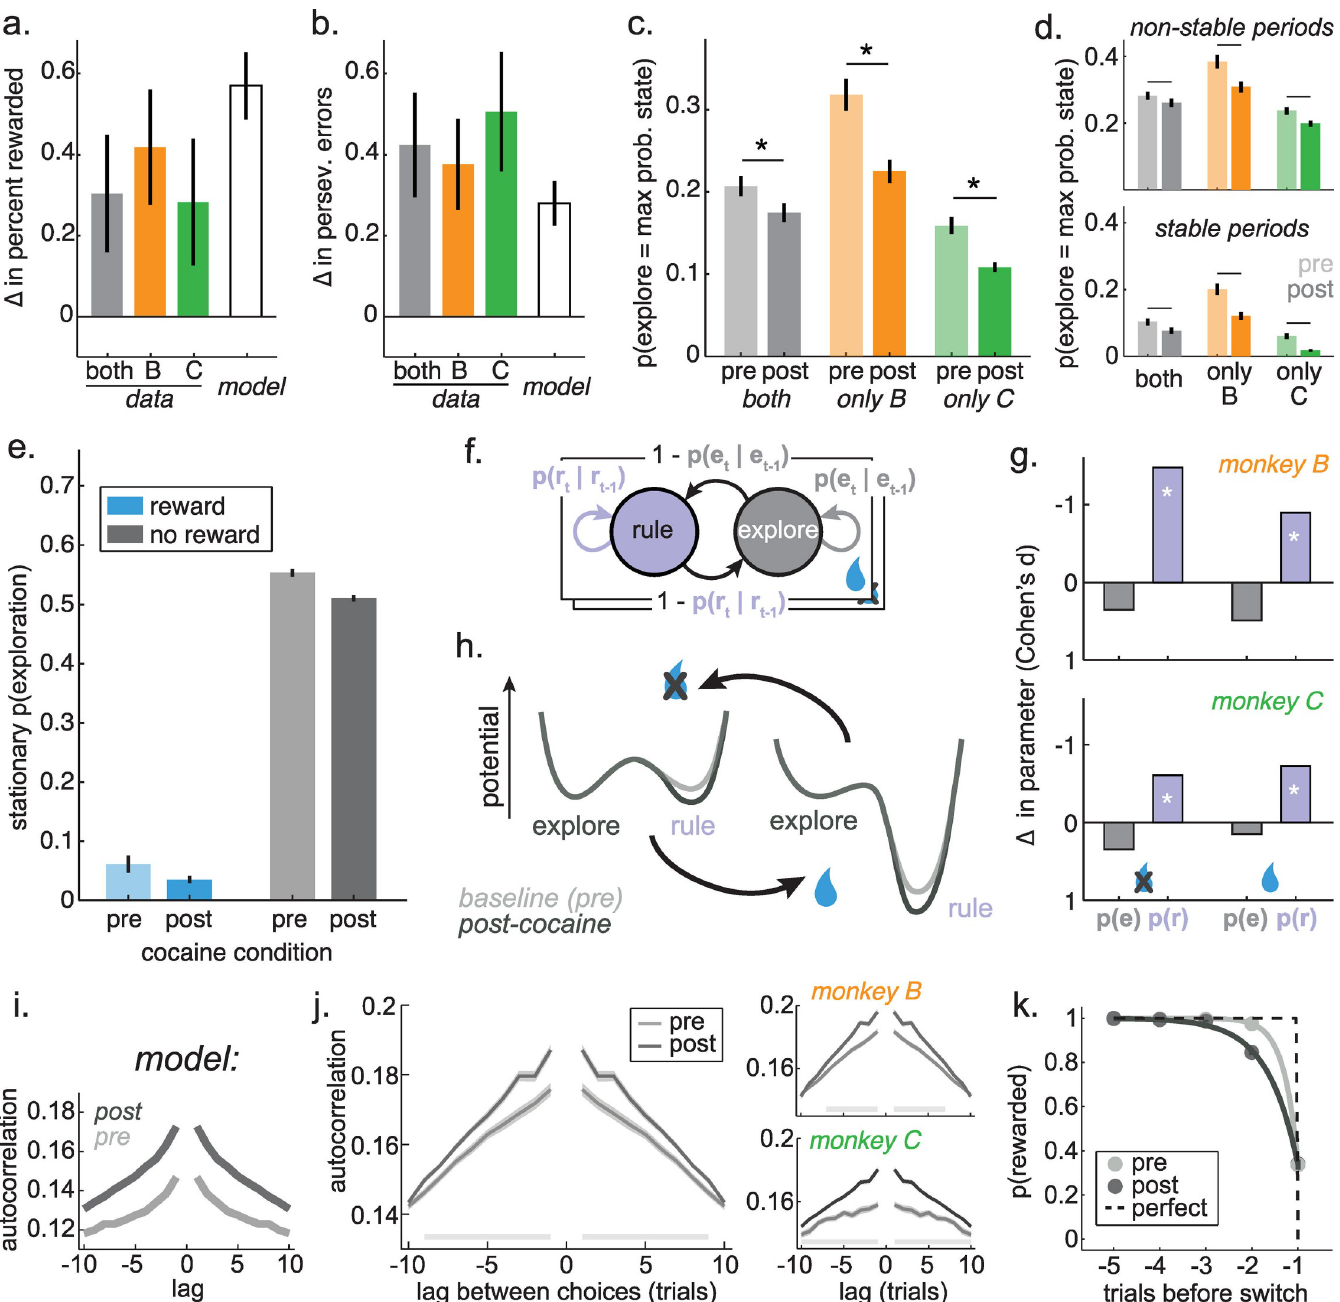
Fig 5. HMM predictions and effects of cocaine on model behavior. A) The increase in the probability correct after cocaine. Plotted separately for both monkeys together (gray bar), monkey B (orange) and monkey C (green), next to the increase in probability correct in simulated data from the model (white bar). Bars: Satterthwaite approximation of the +/ 99 CI. B) Same as A, for change in perseverative errors. C) The probability that exploration was identified as the most probable cause of each choice, before and after cocaine. Gray = both monkeys together, orange = monkey B, green = monkey C. Bars +/- SEM. D) Same as C, but with explore choices separated according to whether these occurred during stable periods (10 trials before change point; bottom) or elsewhere in the task (top). E) The stationary probability of the explore state, given the outcome of the previous trial (rewarded = blue, not rewarded = gray) and the cocaine condition (pre = before cocaine, post = after). F) Illustration of the 2 free parameters in each plate of the model (4 parameters total). E) Effect of cocaine on the model parameters. Change in parameters (Cohen’s d, post-cocaine minus baseline) in monkey B (top) and monkey C (bottom). � p < 0.05, t-test (see Table 1). Note that the slight decrease in the probability of staying in exploration was likely due to practice (see Results). H) A cartoon illustrating the effect of cocaine on model parameters (see Table 1) in terms of an attractor landscape. Here, exploration and rule adherence correspond to some local minima in a behavioral landscape, across which the monkeys move stochastically. Reward outcomes act to shift the baseline landscape (light line) from strongly favoring rule adherence following reward delivery (left) to a slight preference for